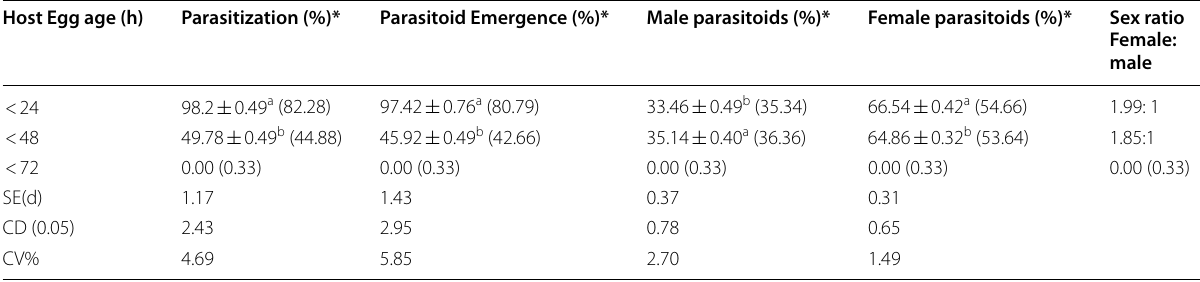
Values represent means of thirteen replications *Values in parenthesis are arcsine transformed values and in columns, means (